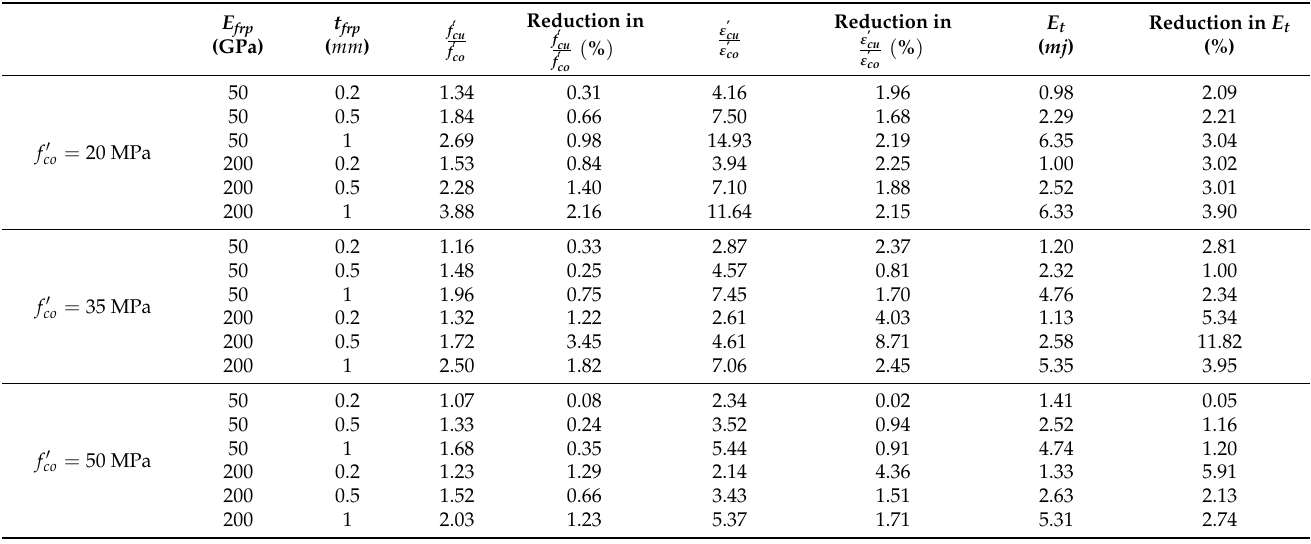
Table A1. FEM results for θ = 2 ◦ .